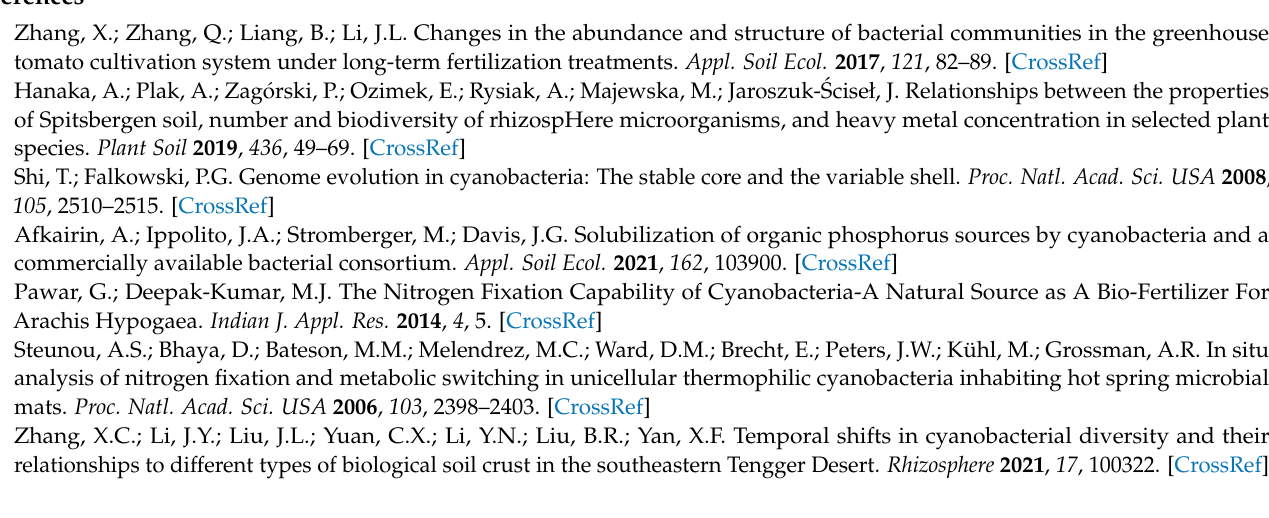
Table S2. Primer sequences and target sites; Table S3. Relative abundance of soil cyanobacteria in different areas of Jilin Province; Table S4. Significance of environmental variables in explaining the differences of cyanobacteria; Figure S1. Phylogenetic evolutionary tree of two isolated cyanobacterial